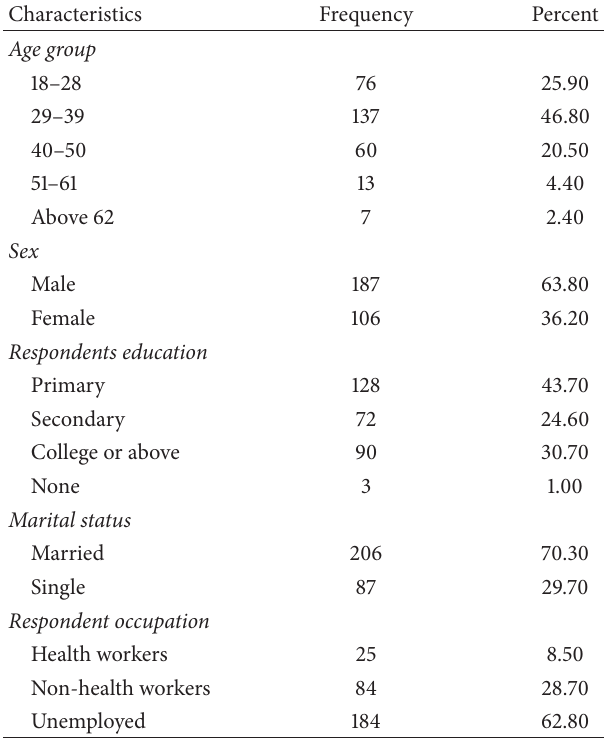
Table 1: Sociodemographic characteristics of the